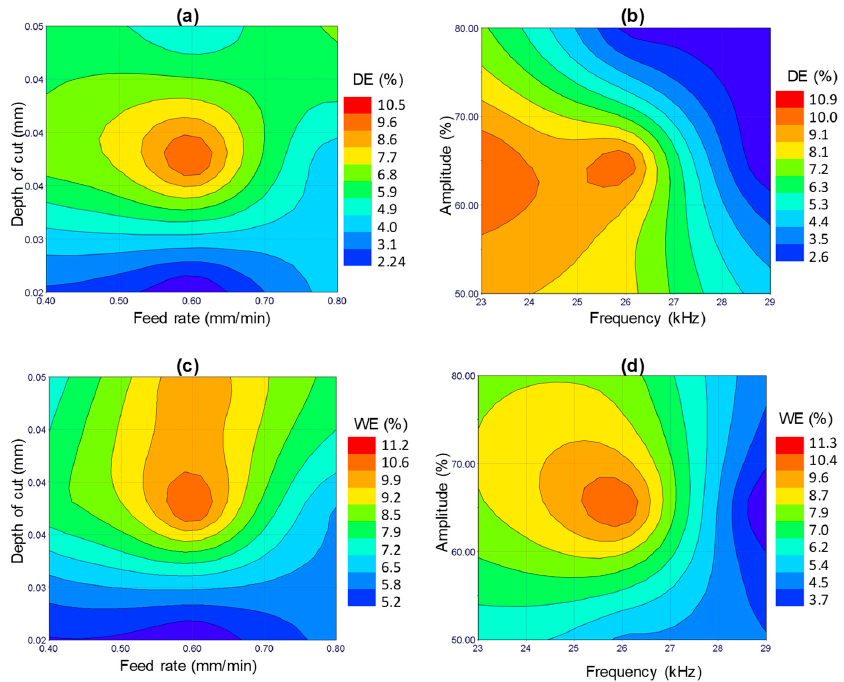
Figure 14. Response surface plots, i.e., effects of the indicated process parameters on ( a ) and ( b ) SEC, and ( c ) and ( d ) BEC.